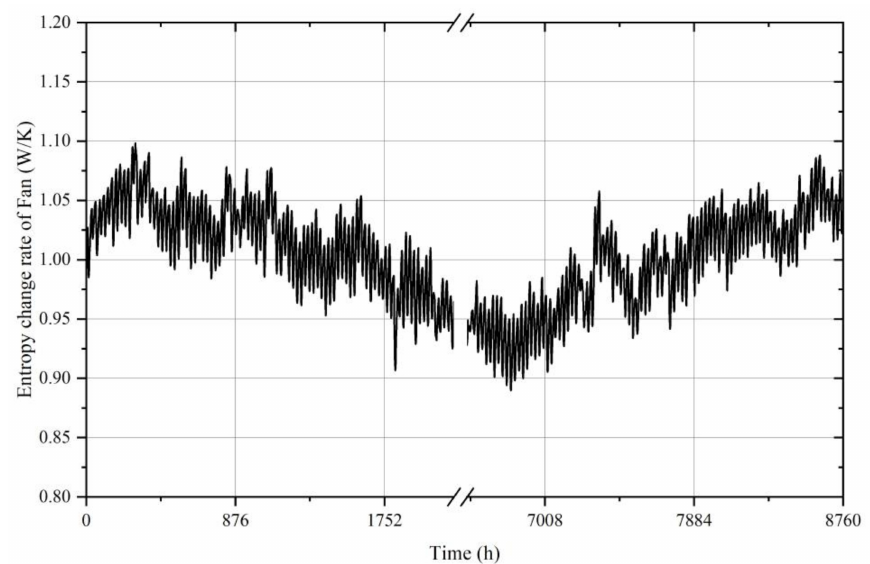
Figure 12. Entropy change of fan in heating